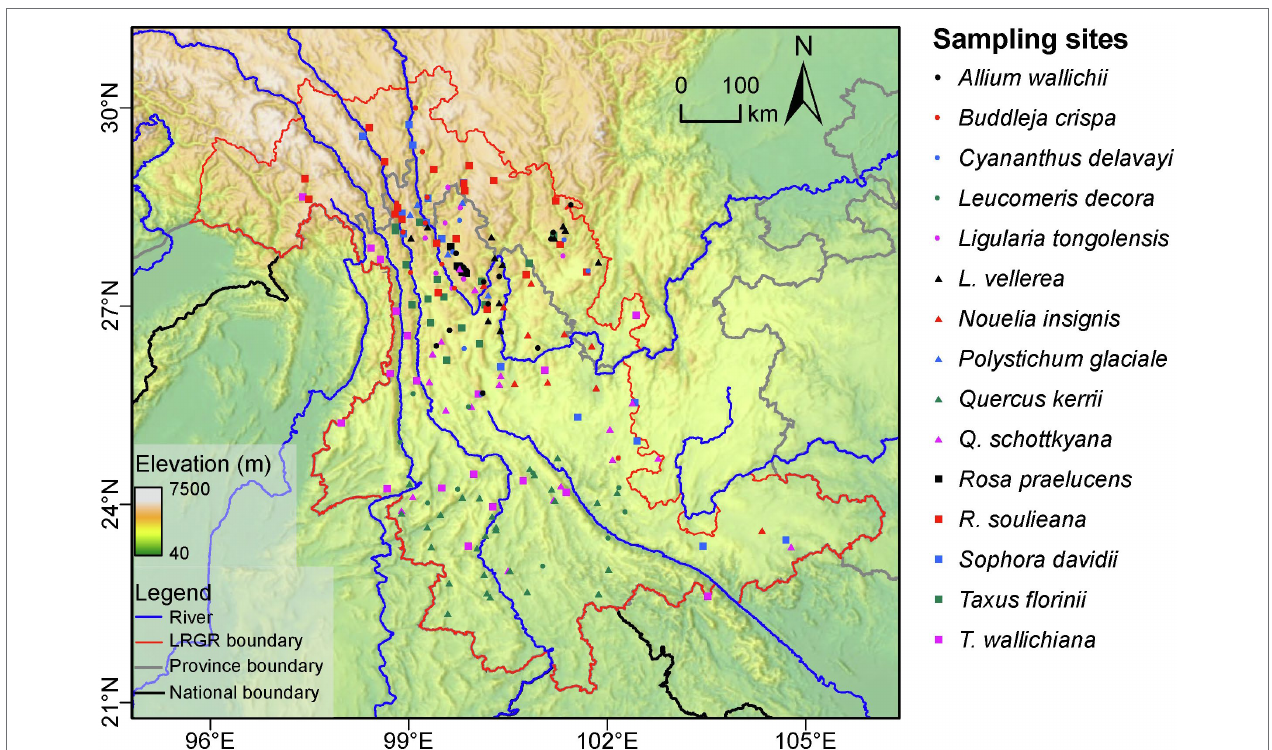
FIGURE 1 | Map of the study area showing the distribution of the 15 species in the Longitudinal Range Gorge Region (LRGR).